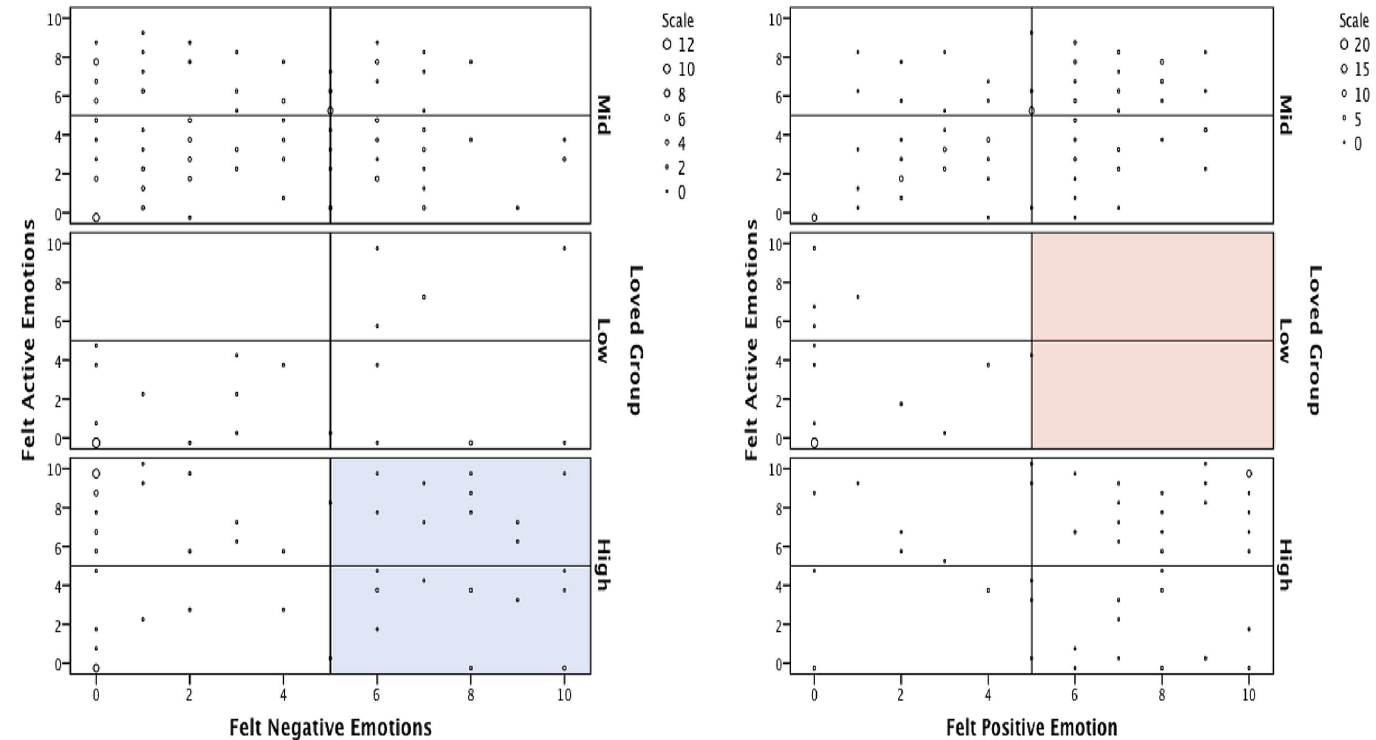
Fig 1. Density plots of felt negative or positive emotion against felt active emotion by Loved rating groups. Note that the blue region denotes the high felt negative emotion density cell for the High loved group (24 cases), and the red region denotes the ‘symmetric opposite’high felt positive emotion density cell for the Low loved group (i.e. disliked) (0 cases). The comparisonof these two regions demonstrates that the spread of negative emotions experienced in response to loved music is relatively large.